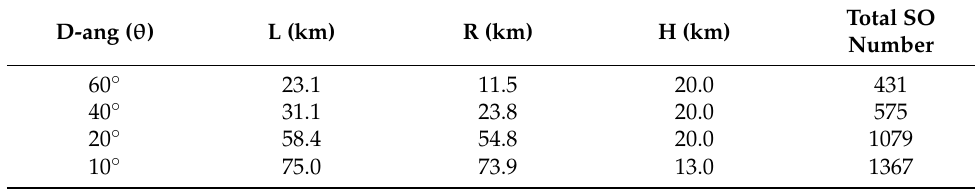
Table 2. The detection range (L), horizontal scanning radius (R), vertical scanning depth (H), and total radar SO number in various radar D-ang